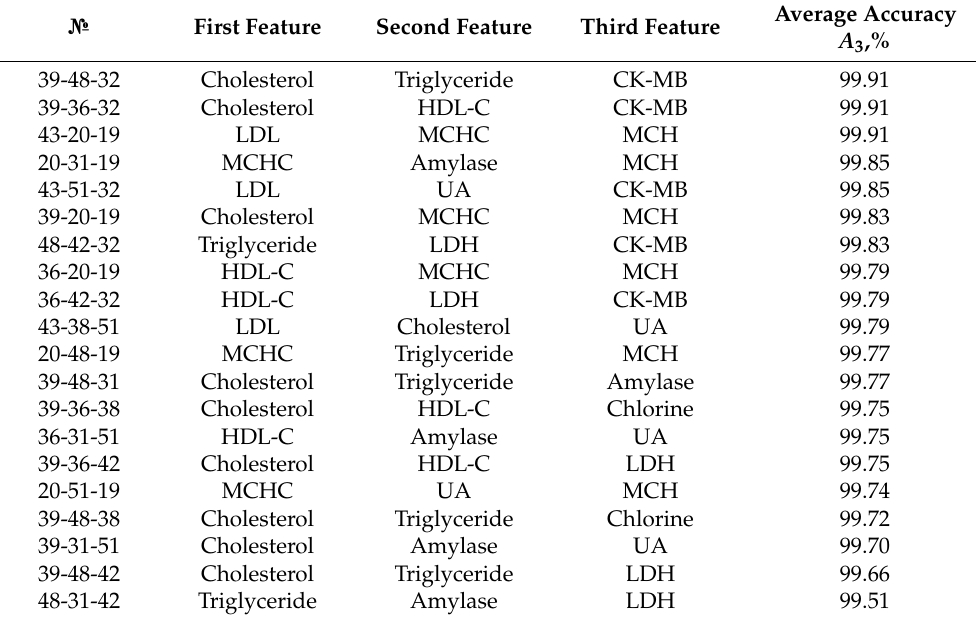
Table 8. Classification efficiency of SARS-CoV-2-RBV1 dataset using 3 features for the Histogram- based Gradient Boosting